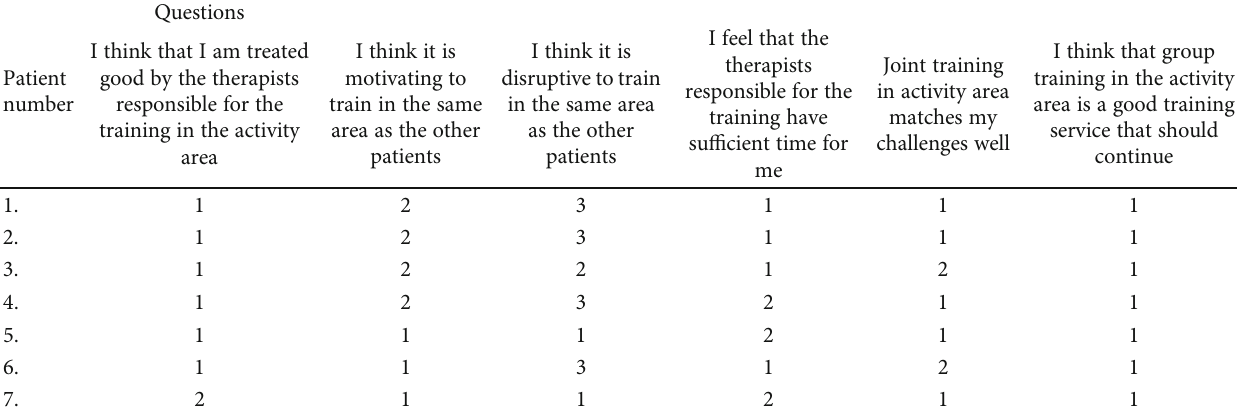
Table 6: Questionnaire: “ Your experience of the Activity block – group training ”